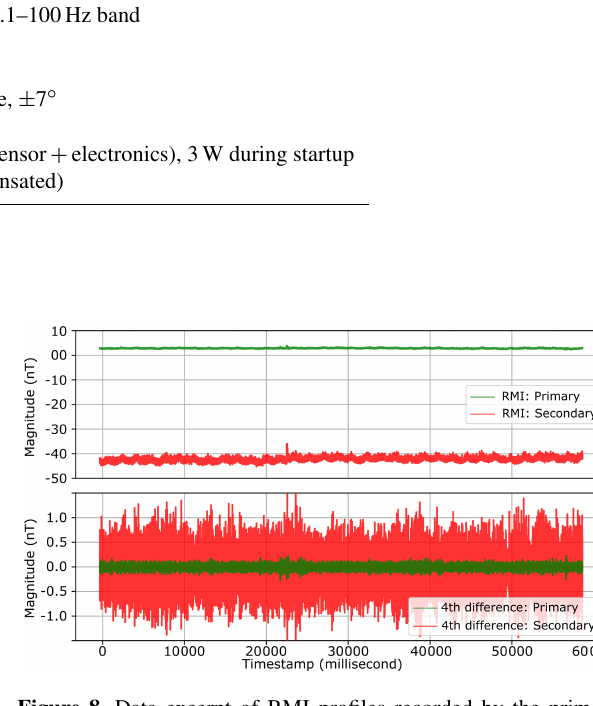
Figure 8. Data excerpt of RMI profiles recorded by the primary and secondary magnetometer and their respective fourth difference while the UAV was on standby on 13 January 2020 with d = 20cm and L = 20cm. The IGRF (50560nT) has been removed.